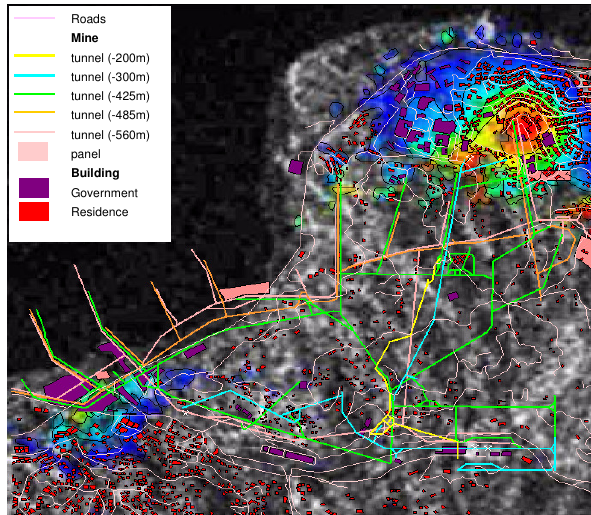
Table 1. Distribution of the structures into the deformation zones Deformation zone